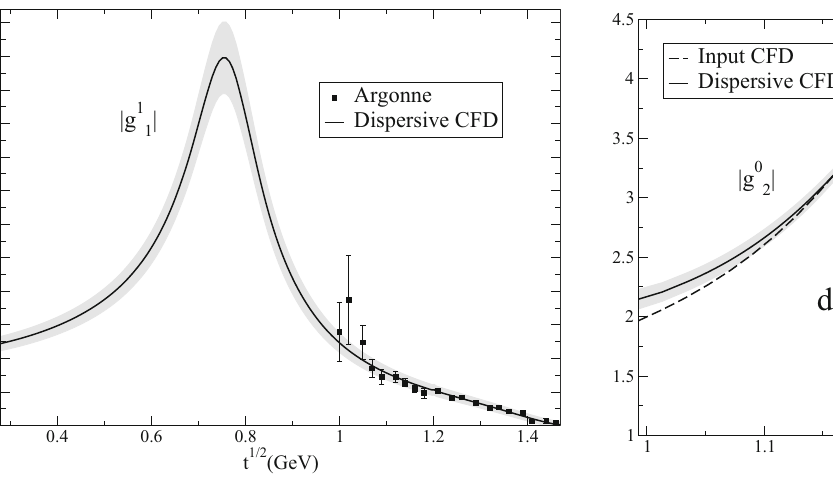
Fig. 10 Dispersive output for the modulus of the g 1 partial wave obtained from the CFD set. The continuous line and the uncertainty band corresponds to the CFD dispersive result